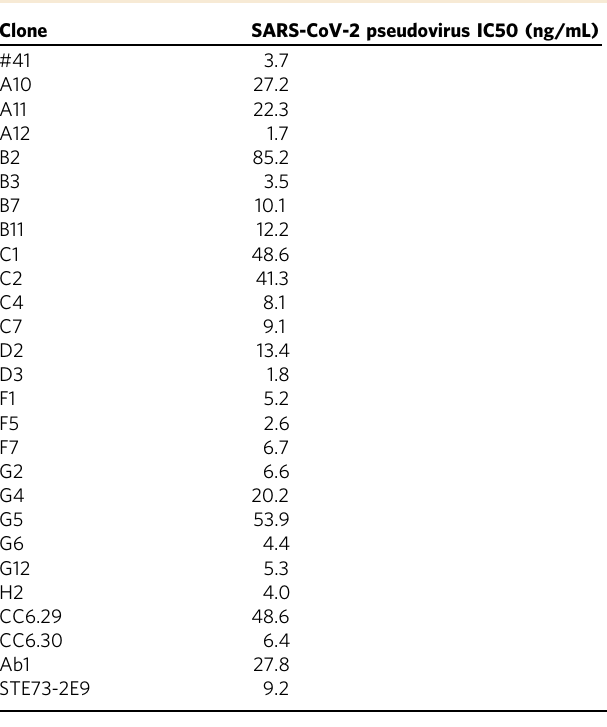
1.7 to 85.2 ng/mL. Eleven of the antibodies selected here were more potent than CC6.29 and CC6.30 (IC 50 s 48.6 and 6.4 ng/mL) when directly compared in the same assay, and more potent than the antibodies generated from other naïve recombinant antibody libraries, among which we were able to measure IC 50 s for only two: Ab1 (IC 50 = 27.8 ng/mL) and STE73-2E (IC 50 = 9.2 ng/mL). Figure 4a shows the neutralization pro fi les of a subset of ten antibodies, chosen for their binning and af fi nity properties.